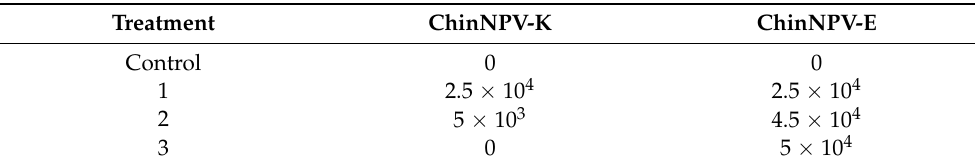
Table 2. Concentrations of ChinNPV-K and ChinNPV-E in inoculum mixtures with a total concentra- tion of 5 × 10 4